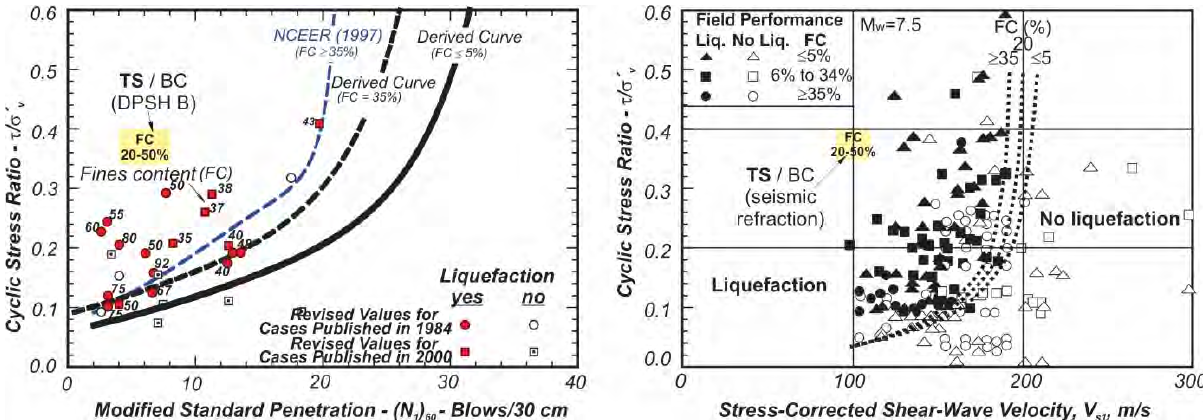
Figure 5. Relationship between cyclic stress ratios causing liquefaction and ( N 1 ) 60 (after Seed and Idriss [14]) and the position of the top soil in it (left). Relationship between cyclic stress ratios causing liquefaction and shear wave velocity values (after Seed and Idris [14], Youd et al. [16] and Andrus [17]) and the position of the top soil in it (right). BC – before compaction, FC – fines content, TS – top soil layer.